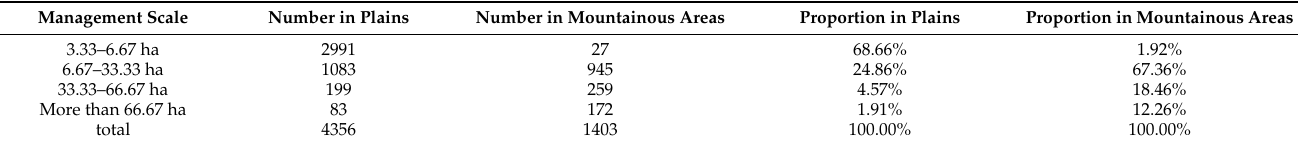
Table 5. Number of scale management units of farmland circulation (unit: